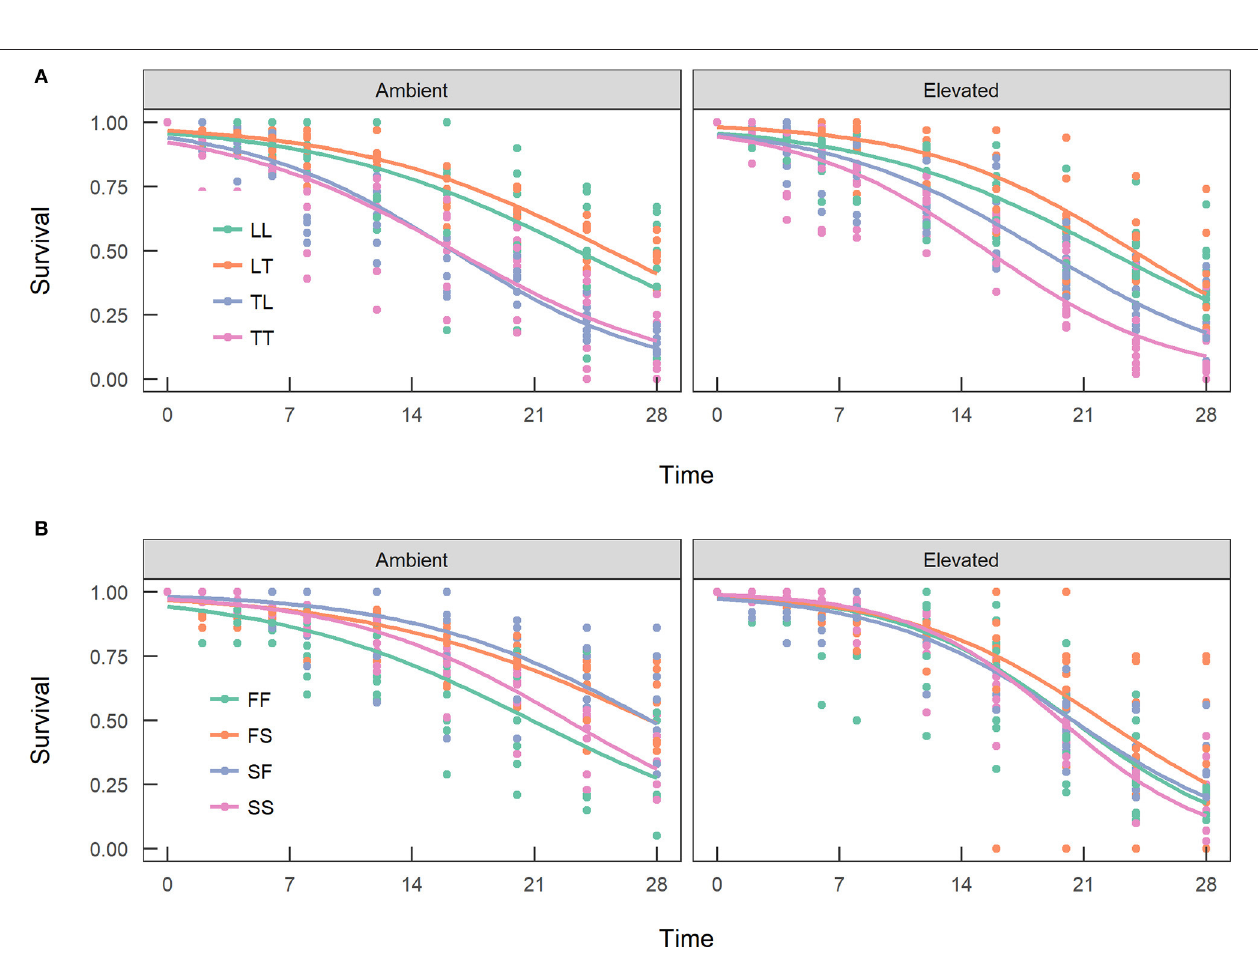
FIGURE 4 | Survival of the offspring groups of (A) the Acropora tenuis (T) × Acropora loripes (L) cross, and (B) the Acropora sarmentosa (S) × Acropora florida (F) cross under ambient and elevated conditions across 28 weeks. The abbreviation of the offspring groups is that the first letter represents the origin of the eggs and the second letter the origin of sperm. Lines represent the estimates of the longitudinal generalized linear models.